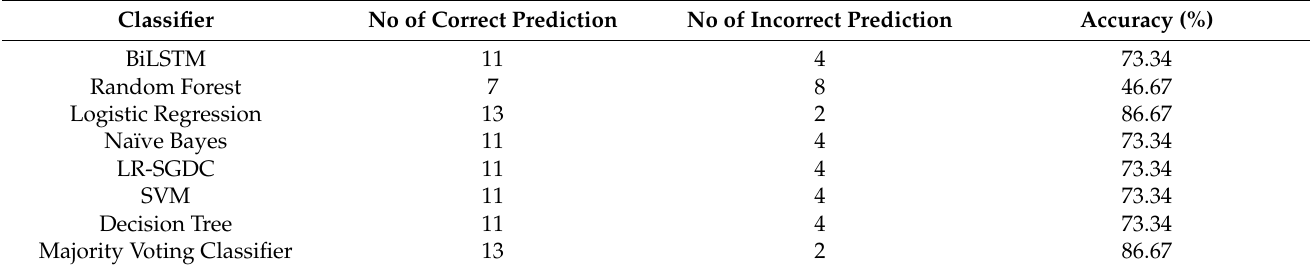
Table 11. Prediction by second